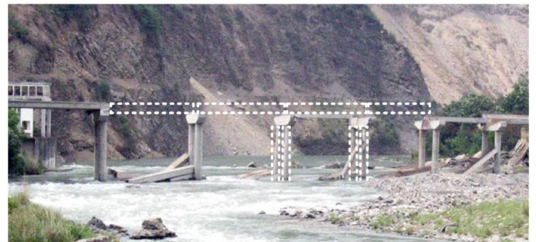
Figure 1. Falling beam at Nanba Bridge in the Wenchuan Earthquake.